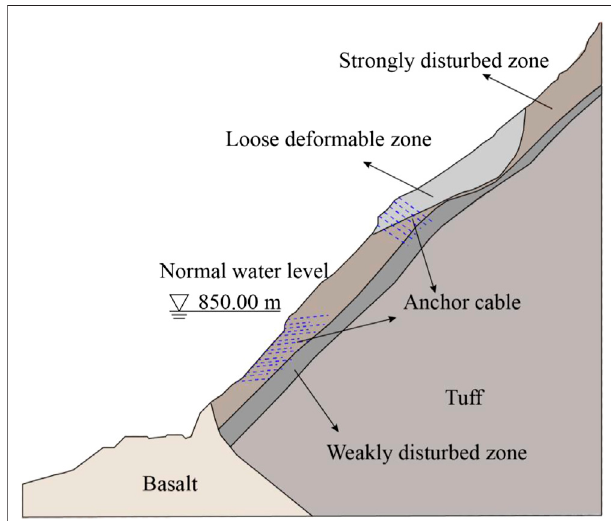
FIGURE 4 | Typical pro fi le of the slope.